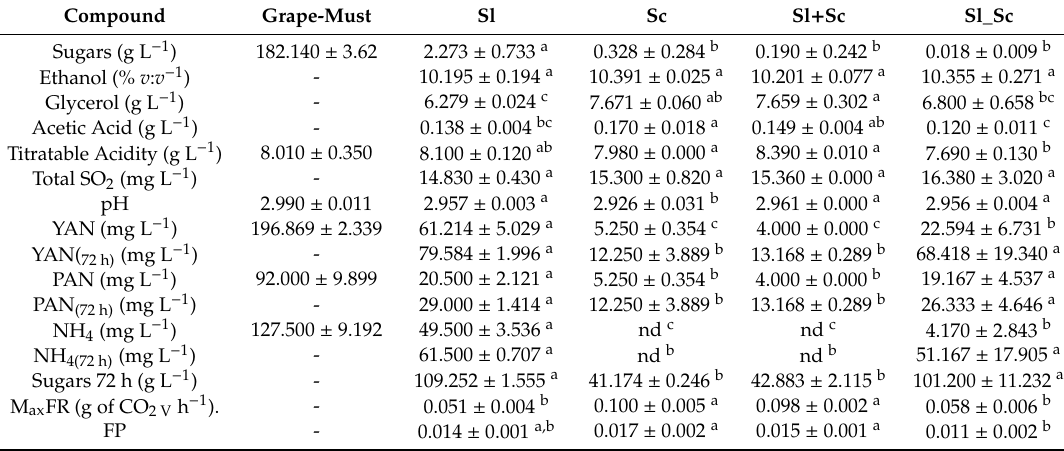
Table 1. Physicochemical composition of initial grape-must and wines obtained by single-cultures of S. ludwigii UTAD17 (Sl) and S. cerevisiae QA23 (Sc) or in consortium—mixed simultaneously (Sl + Sc) and sequentially (Sl_Sc) in natural grape-juice of Vitis vinifera L. cv. Touriga Nacional at 25 ◦ C under static